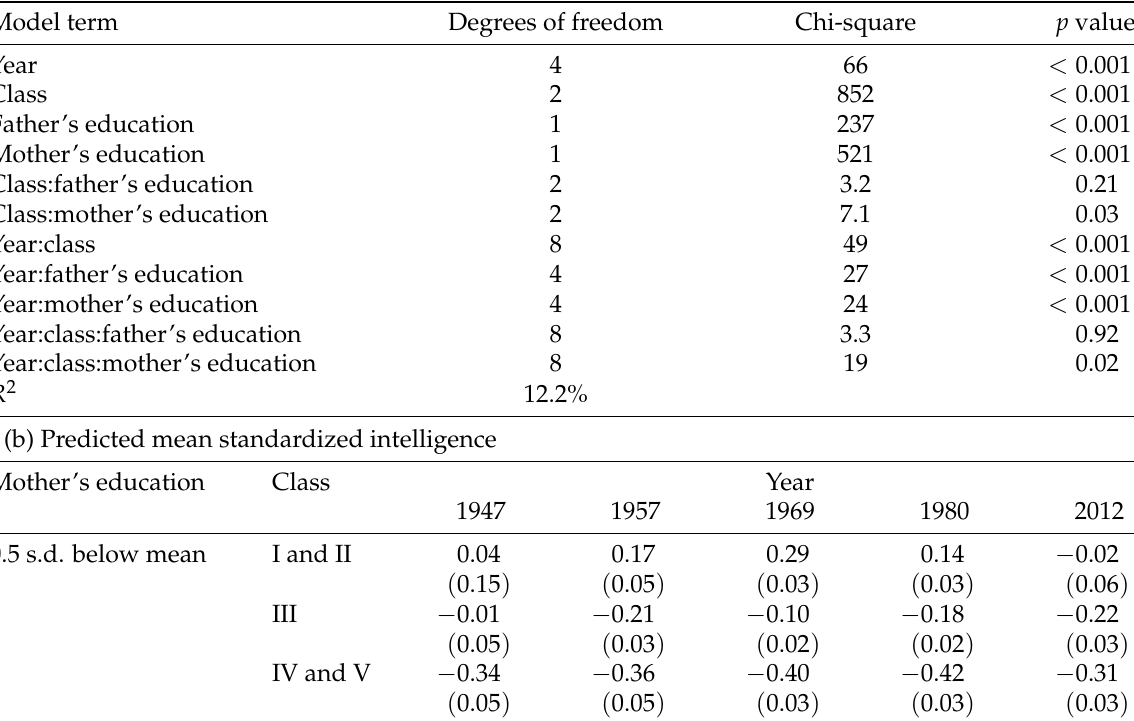
Table 4: Model of standardized intelligence in terms of year, class, and parental education